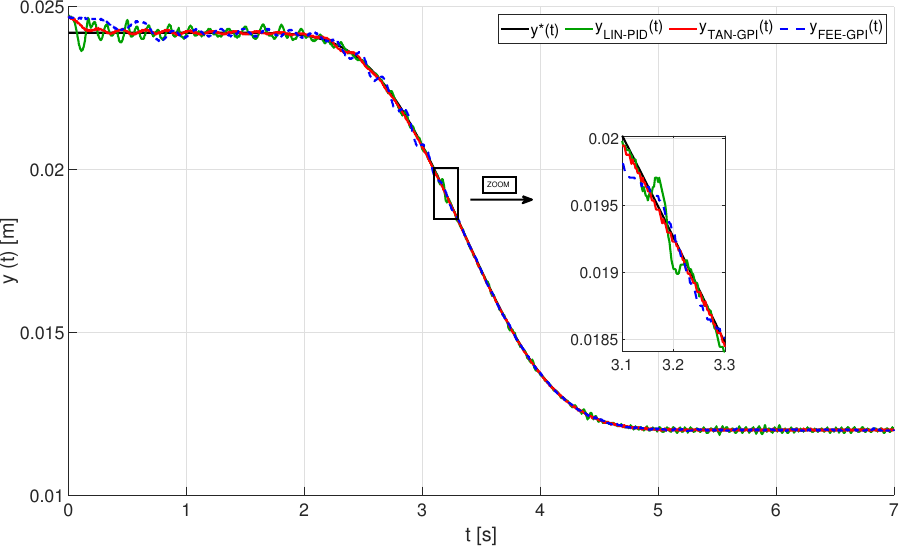
Figure 15. Evolution of the tracking trajectory of the magnetic ball, y ∗ ( t )[ m ] vs. y ( t )[ m ] , (Experimental Test).